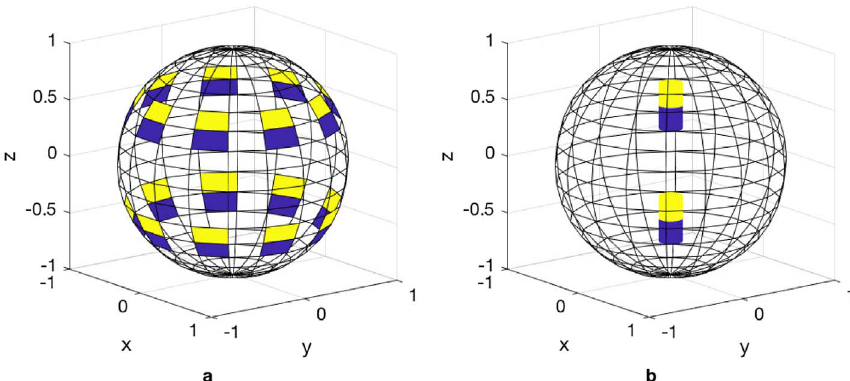
Fig. 1. Two-dipole model. (a) Two rings of surface dipoles representing the north – south magnetic component of decaying active regions in the photosphere at the latitude of about ±30 (cid:3) in an axisymmetric case. (b) Two axial dipoles placed at the center of each dipole ring of panel a. The magnetic potential of the two dipole rings of panel a and of the two axial dipoles of panel b are nearly identical at the